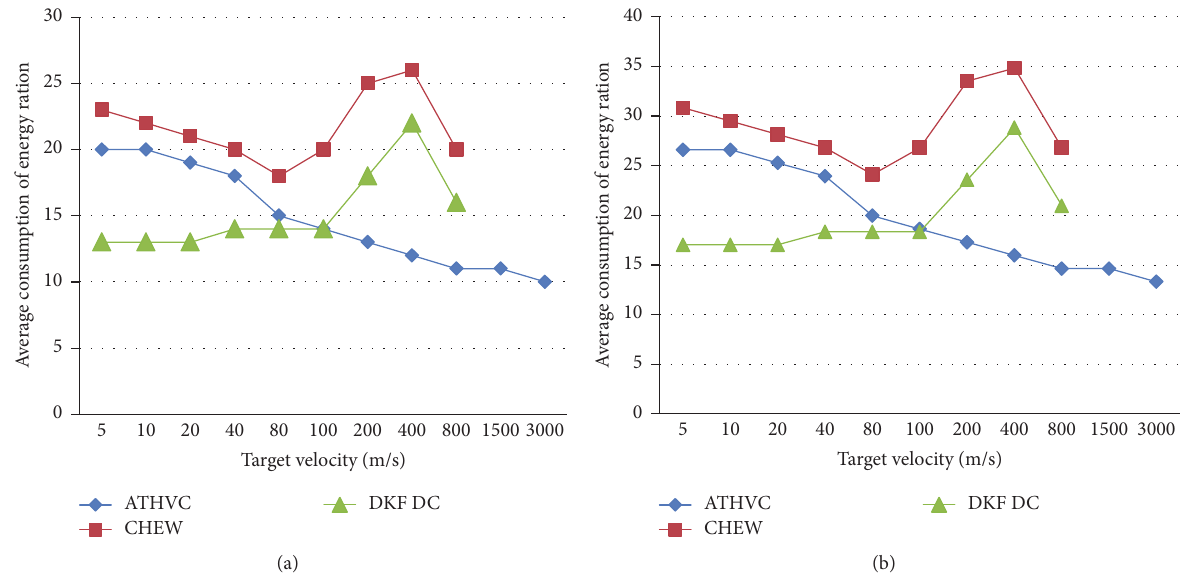
Figure 11: (a) Energy consumption with 1000 nodes. (b) Energy consumption with 2000 nodes.